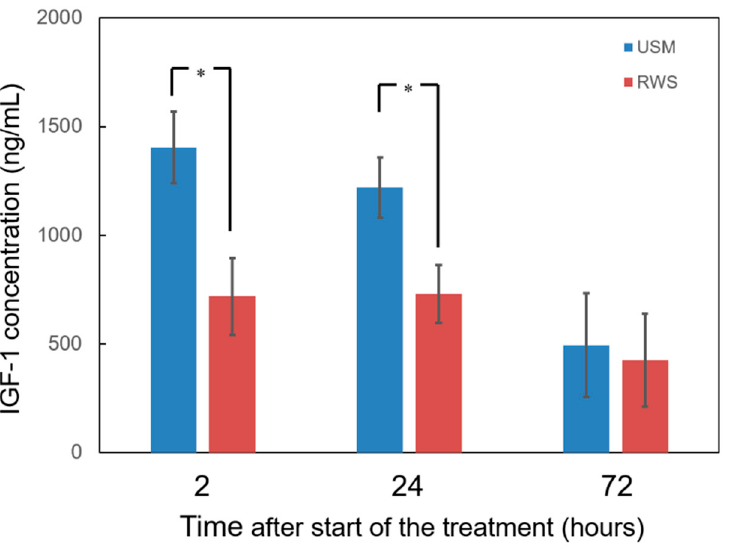
Figure 1. Concentration of IGF-1 in the perilymphatic fluid of the inner ear following IGF-1 treatment with and without ultrasound microbubbles (USMBs). In the USM group, IGF-1 was delivered following USMB treatment. The results are expressed as the mean ± SEM; n = 6 for each bar; * p < 0.05. IGF-1, insulin-like growth factor-1; USM, ultrasound microbubble treatment; RWS, round window soaking.